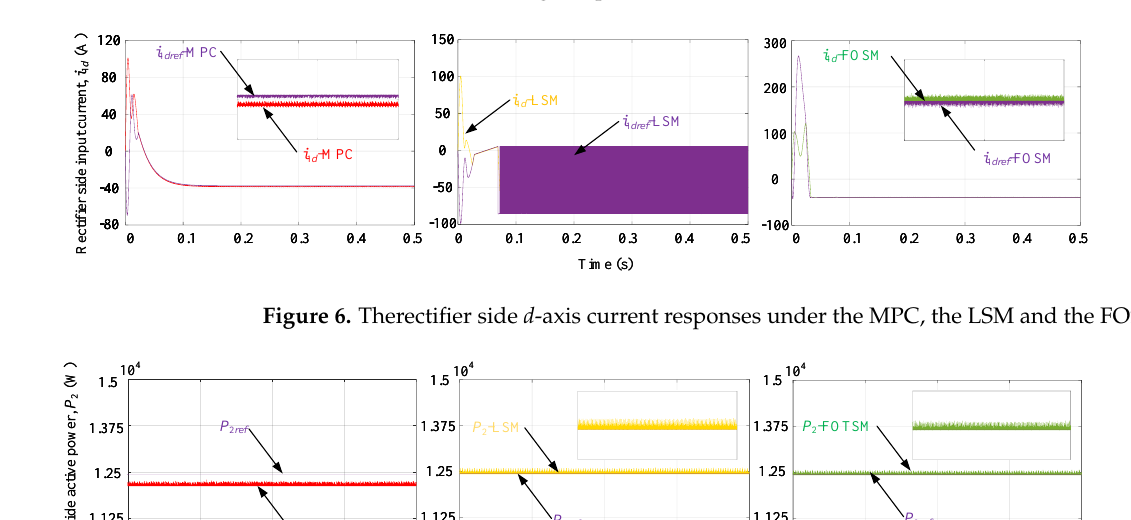
Figure 5. The DC-side voltage responses under the MPC, the LSM and the FOSM.